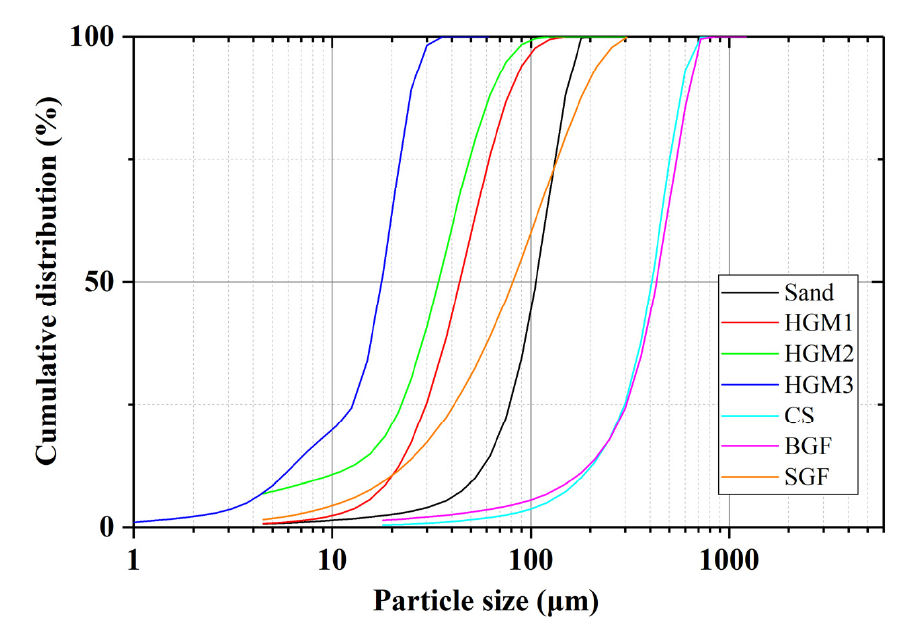
Figure 1. Particle size distribution of HGMs, CS, GFs, and sand.